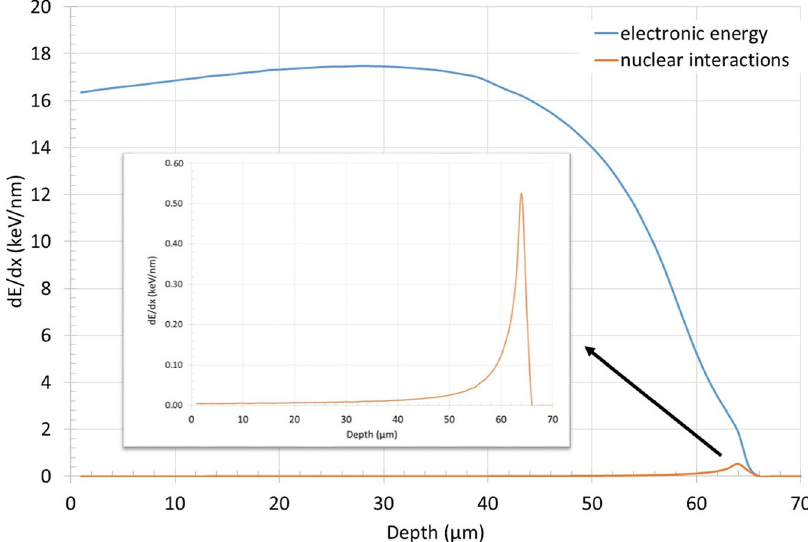
Fig. 13 Energy deposited by Xe irradiation in CJ2 glass. Deposits of electronic energy (in blue) and nuclear energy (in orange) as a function of the depth for the irradiation of the CJ2 glass by Xe ions at 952 MeV. Simulation carried out using the SRIM software. Table 3. Initial experimental conditions.